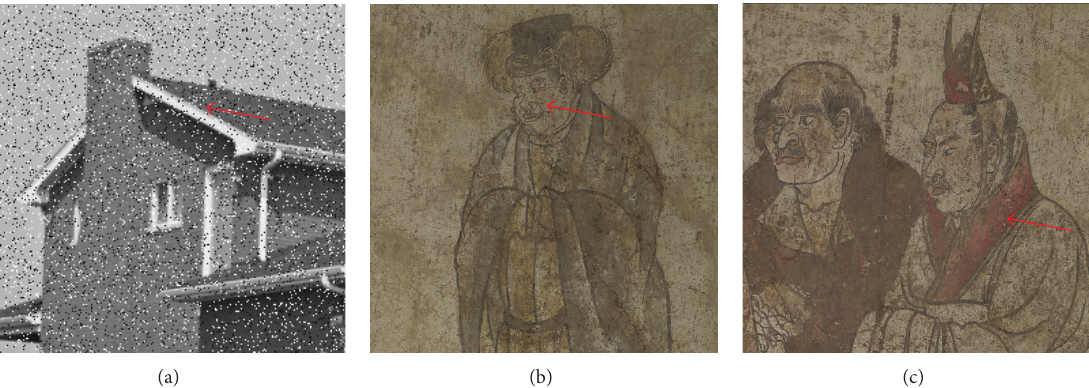
Figure 1: Images with impulse noise. (a) House image with 10% salt-and-pepper noise; (b) and (c) are two mural images.